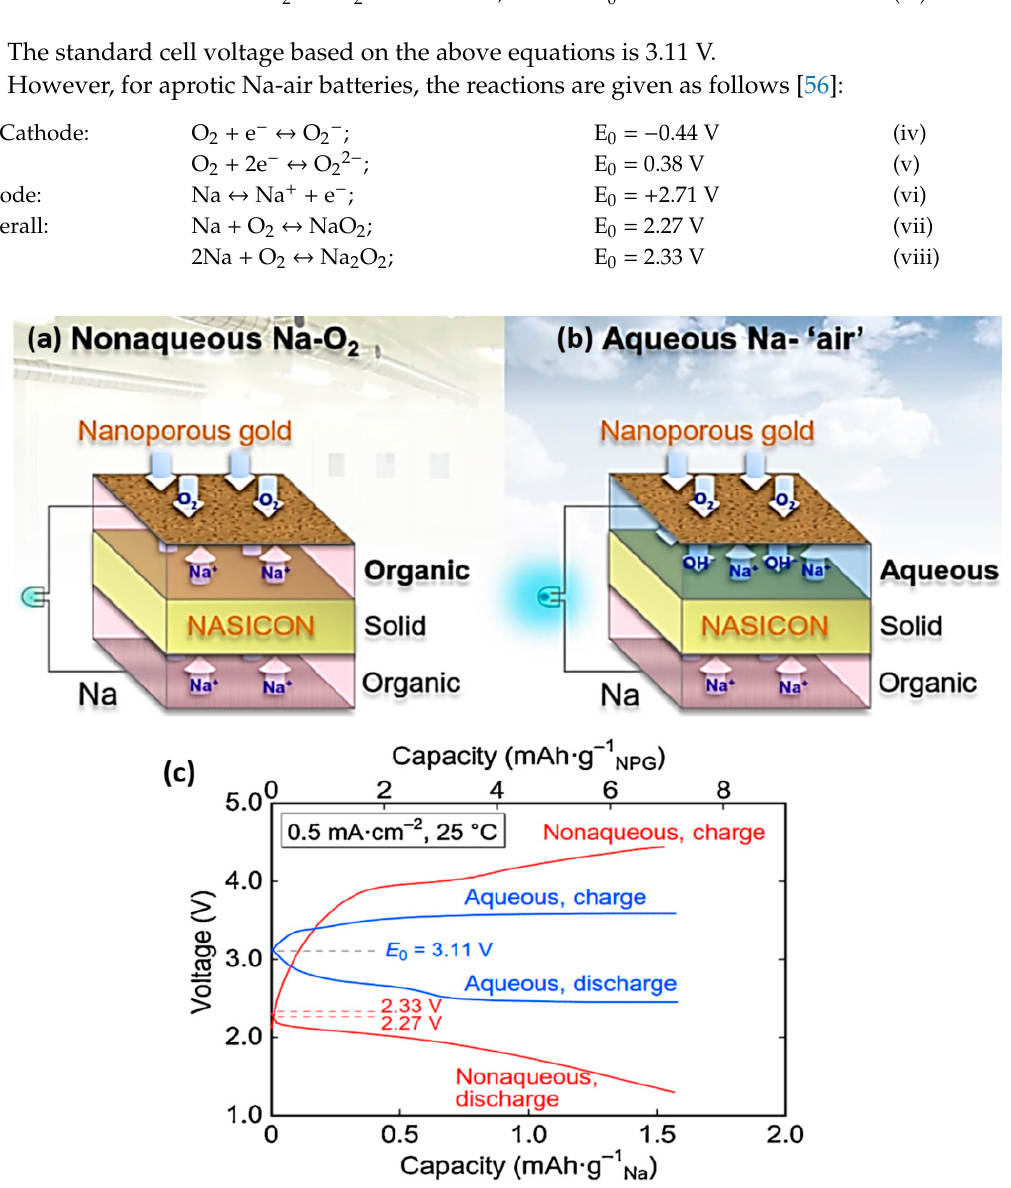
Figure 6. Schematic structure of ( a ) non-aqueous and ( b ) aqueous Na-air batteries with nanoporous gold electrode. ( c ) First discharge charge curves of non-aqueous and aqueous batteries at 0.5 mA · cm − 2 up to 7 mAh · g − 1 NPG [57]. Reprinted from Aqueous and Nonaqueous Sodium-Air Cells with Nanoporous Gold Cathode, 182; Taijyu Hashimoto, Katsuro Hayashi; Copyright 2019, with permission from Elsevier.